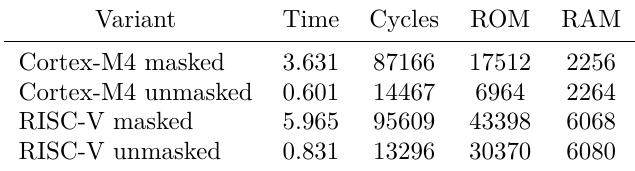
Table 5: Implementation results of the PRESENT cipher on the Cortex-M4 and RISC-V cores. Time is given in milliseconds, ROM and RAM are given in